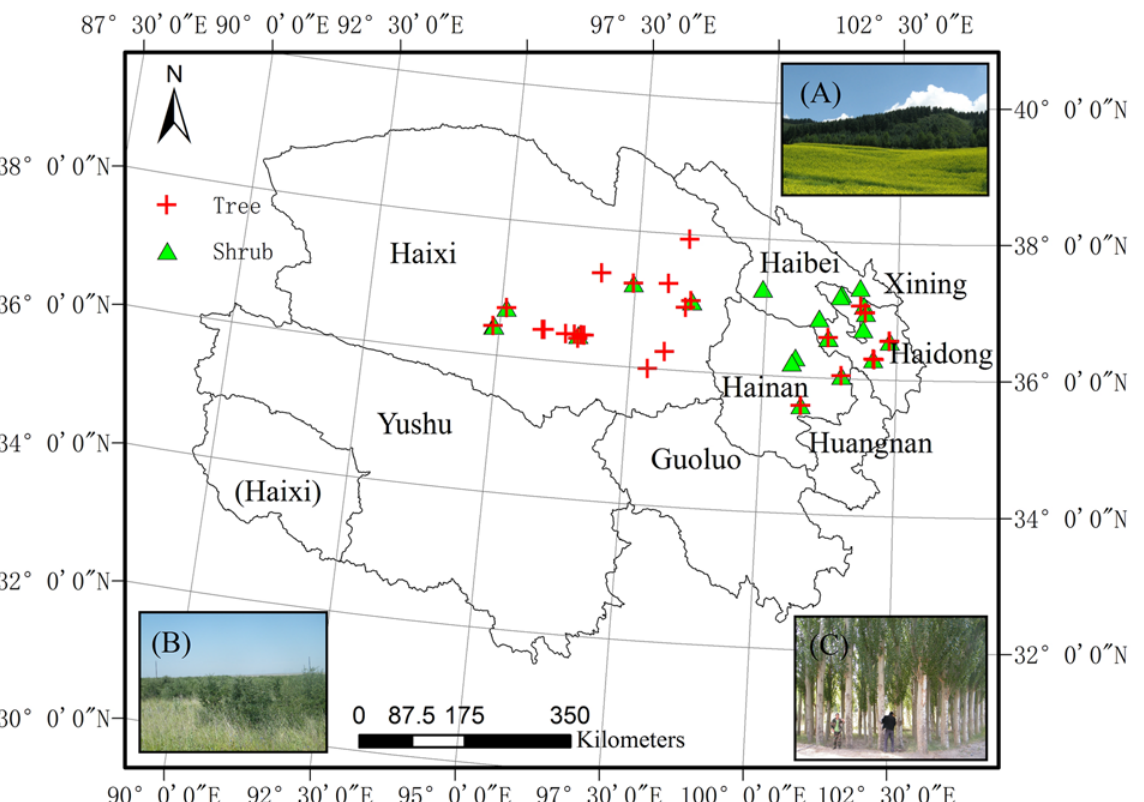
Fig 1. Location of the 48 sample sites in Qinghai province. The three plates in the corners of the map show the typical forest types. (A) A 21-year- old planted forest ( Larch ) under rain-fed conditions in the eastern hilly region, (B) a 9-year-old planted shrubland ( Hippophae rhamnoides ) in the middle region, and (C) a 31-year-old planted forest ( Populus bolleana ) with irrigation in the west